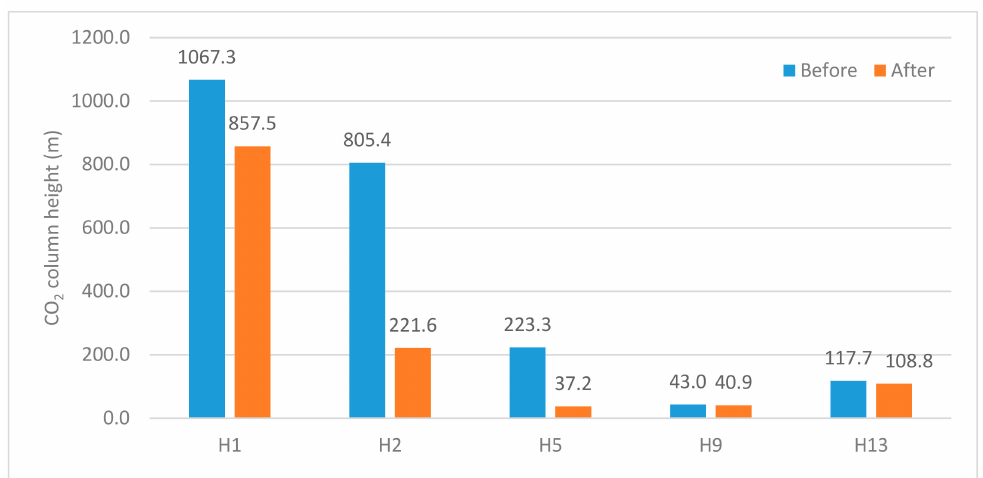
Figure 12. Bar chart showing CO 2 column height (m) for shale samples before and after exposure to scCO 2